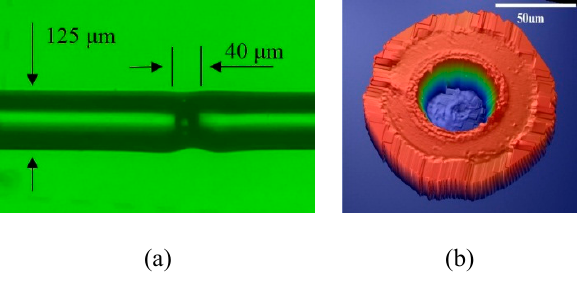
Figure 4. ( a ) Optical microscope photo of an FFPI strain gauge, and ( b ) cross-section view of the laser- etched Fabry–Pérot (FP) cavity.